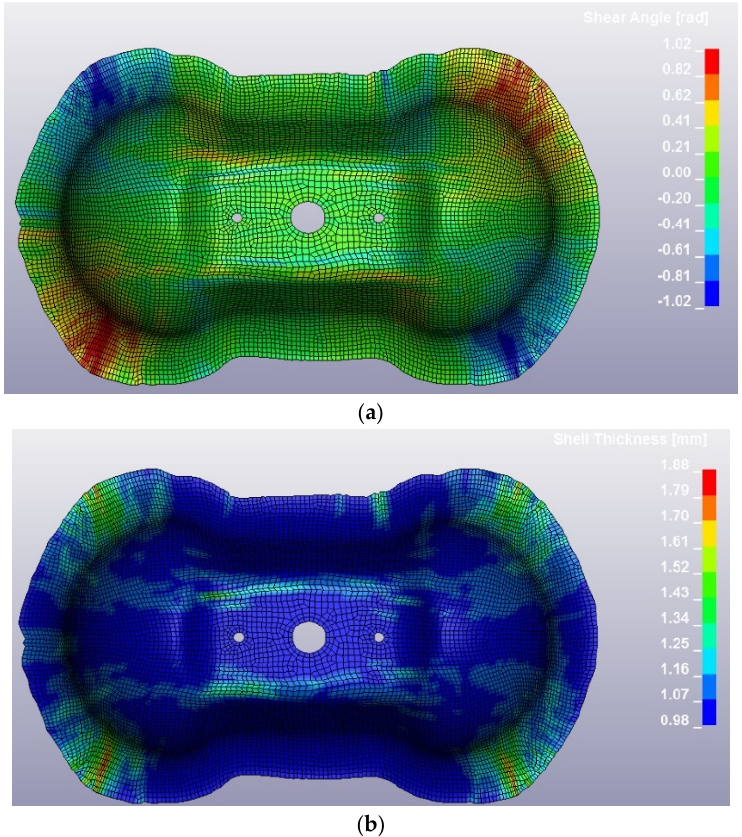
Figure 29. CF/PA66 Double Dome after thermoforming simulation: values of shear angle ( a ) and values of shell thickness ( b ).